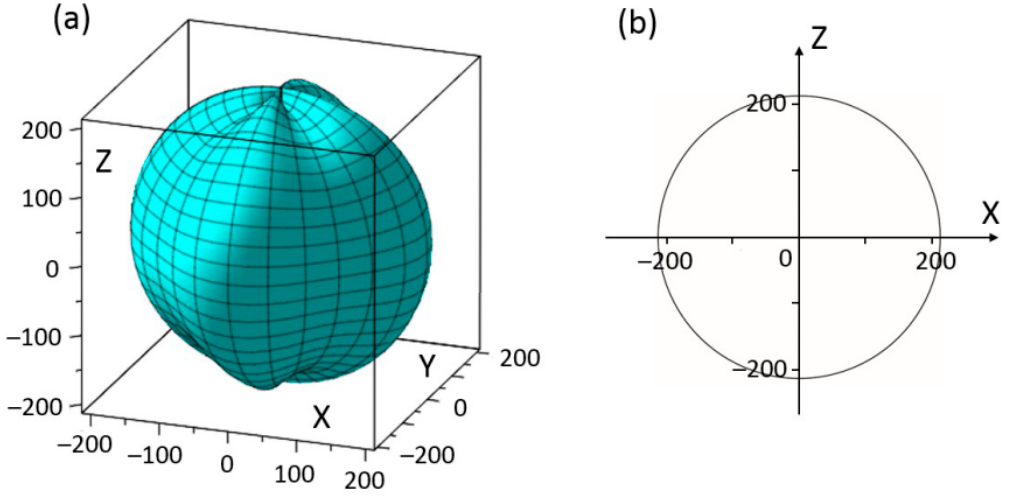
Figure 2. ( a ) Schematic diagram of elastic stiffness c 11 by the experimental data of BiFeO 3 ; ( b ) elastic stiffness c 11 of BiFeO 3 in XOZ plane (also applies to YOZ plane, unit GPa).